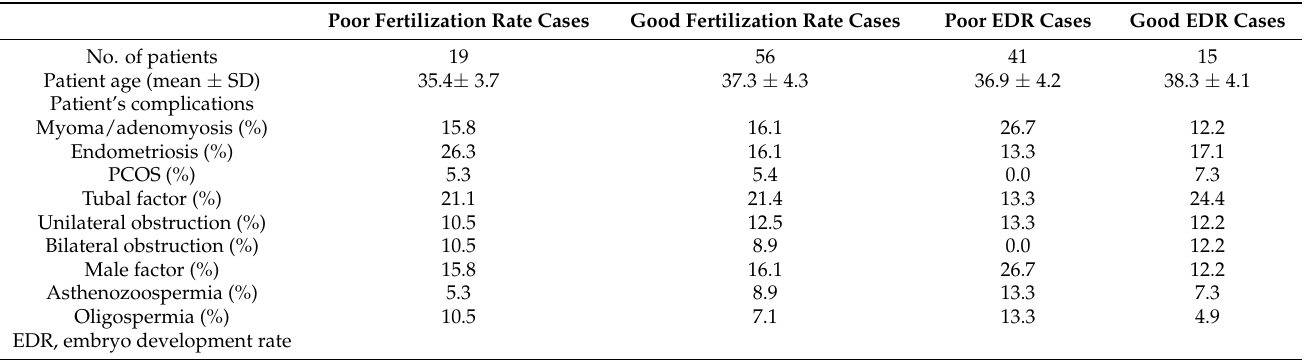
Table 1. Backgrounds of